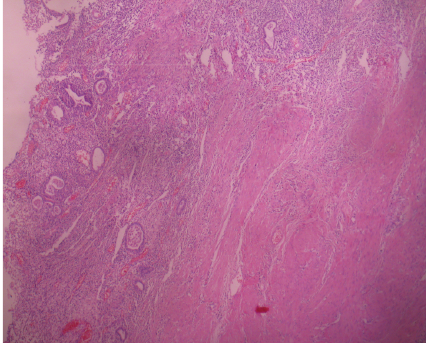
Figure 2: Inflamed endometrium-lined inner surface of uterus-like mass (HE, original magnification is × 40).